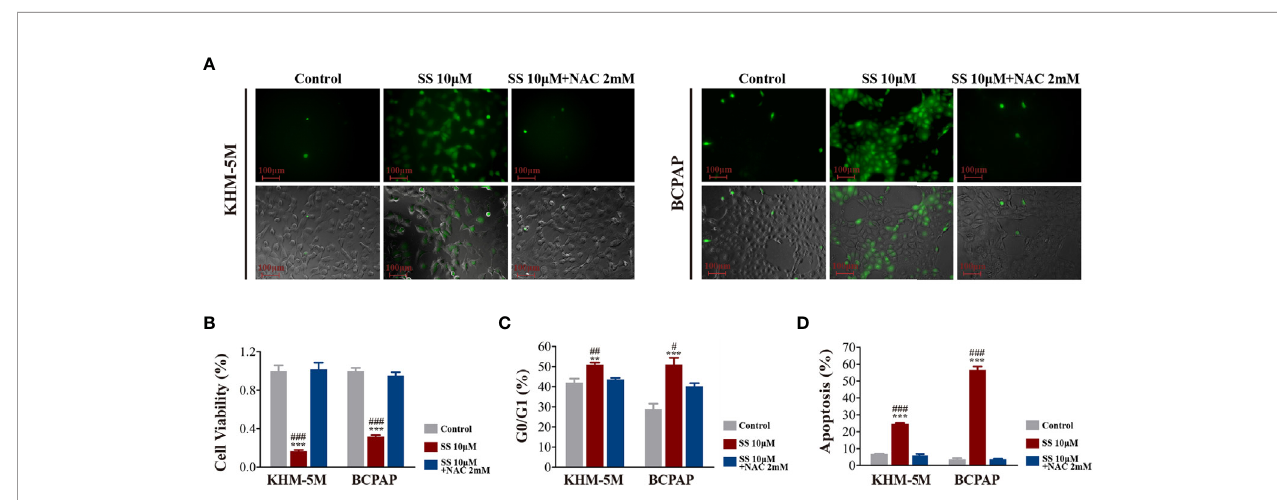
FIGURE 4 | SS induced ROS in thyroid cancer cells. (A) Intracellular ROS levels detected by the ROS-sensitive fl uorescent dye dichloro fl uorescein diacetate (DCFH- DA) after incubation with SS or SS+NAC (2 mM) for 6 h. (B) Cell viability based on CCK8 assays, (C) cell cycle distribution based on fl ow cytometry, (D) apoptosis based on fl ow cytometry were detected after incubation with SS, PBS (control), or SS+NAC (2 mM) for 24 h. Data are expressed as mean ± SD. **P < 0.01; ***P < 0.001 vs control; # P < 0.05; ## P <0.01; ### P < 0.001 vs SS+NAC group. SS, sodium selenite; NAC,